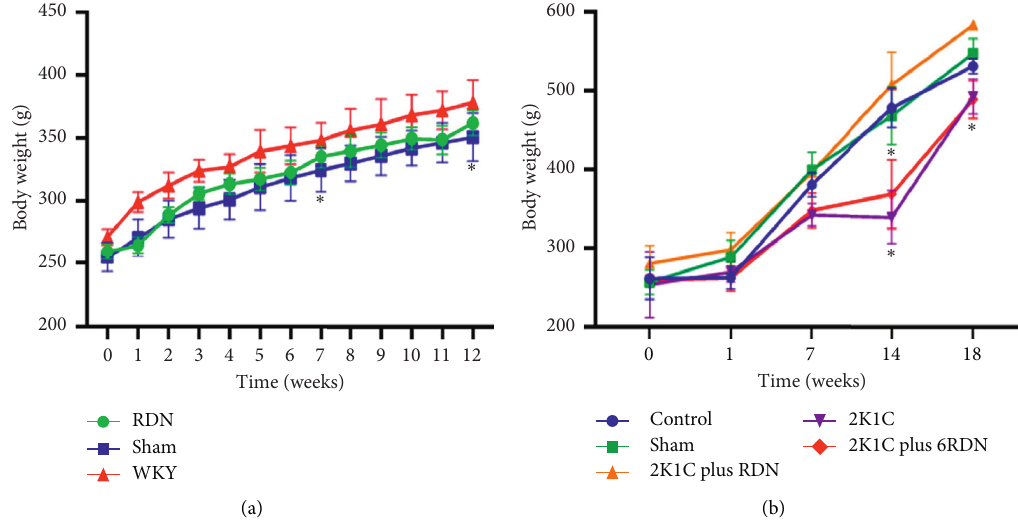
Figure 1: The comparison of bodyweight in SHR and SD rats. (a) The comparison of bodyweight in SHR ( n � 24). ∗ p < 0 . 05 vs. the sham group. (b) The comparison of bodyweight in SD rats ( n � 100). ∗ p < 0 . 05 vs. the sham